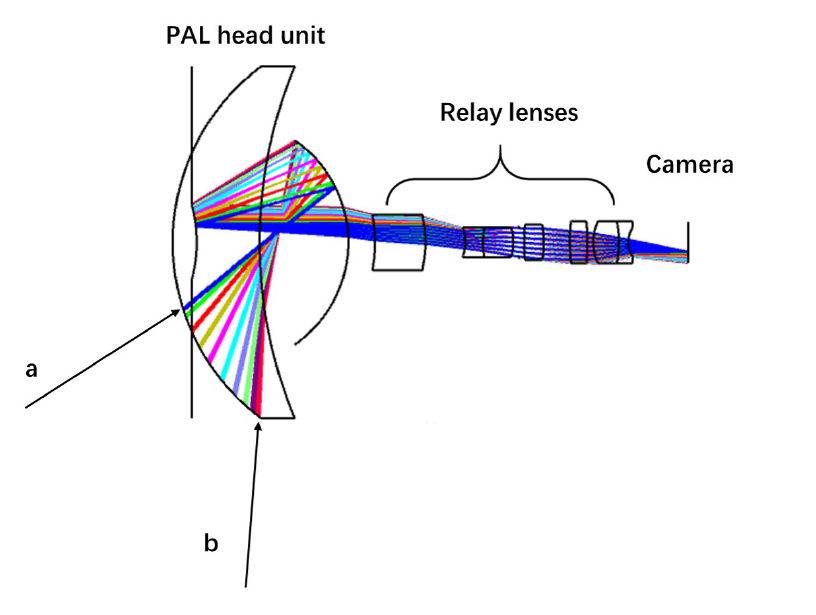
Figure 3. Basic structure and the imaging optical path of PAL (a and b represent the maximum incident angle range of